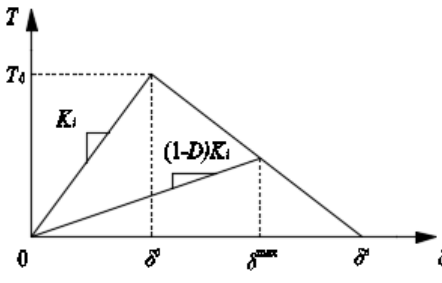
Figure 1. Bilinear cohesive zone model.